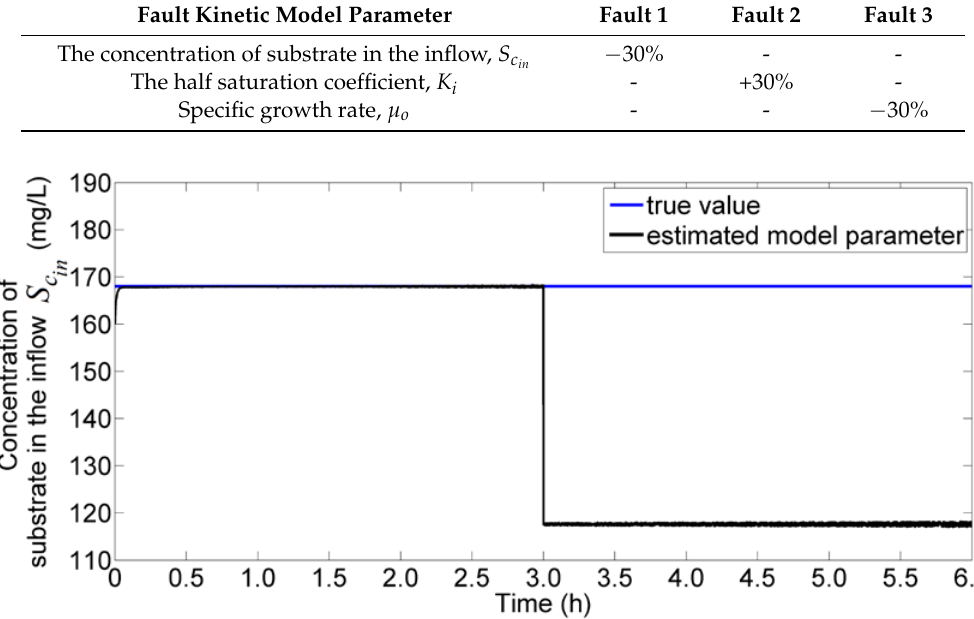
S for faulty scenario 1. Figure 5. Estimated model parameter S c in for faulty scenario 1. in c